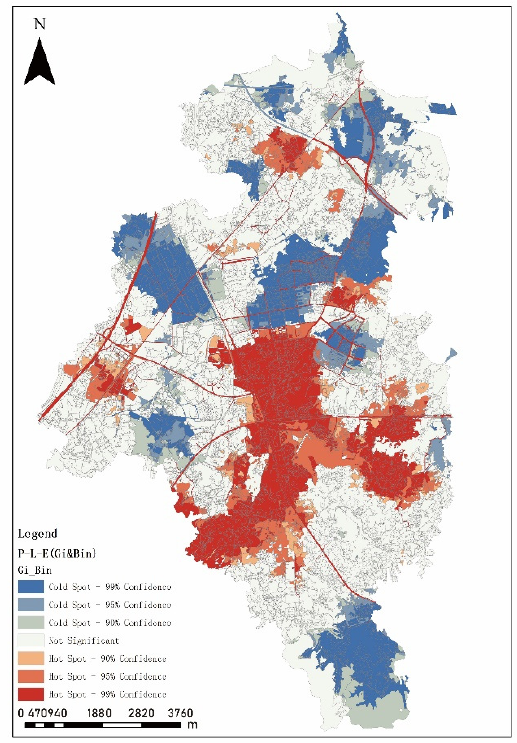
Figure 9. Identification of cold/hot spots of PLE functions.